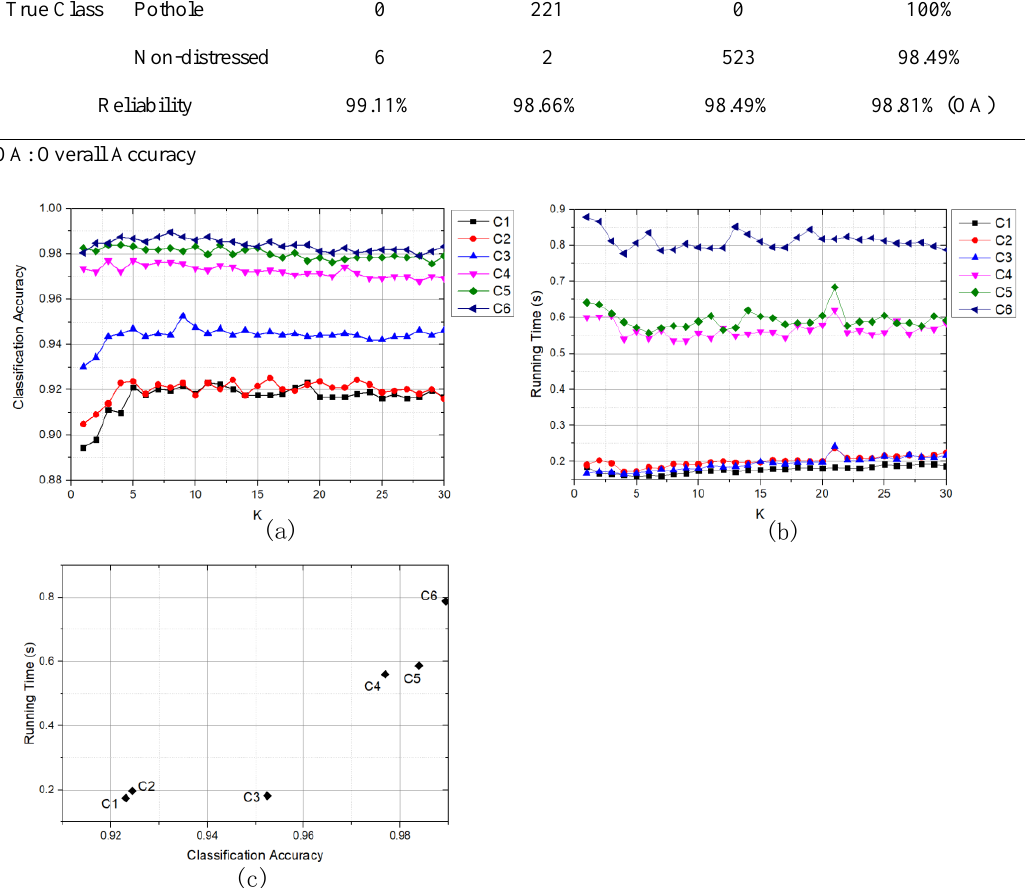
Figure 1. (a) The classification accuracy and (b) running time of KNN with respect to different K, and (c) the relationship between running time and accuracy of the best performance of each of six feature combinations